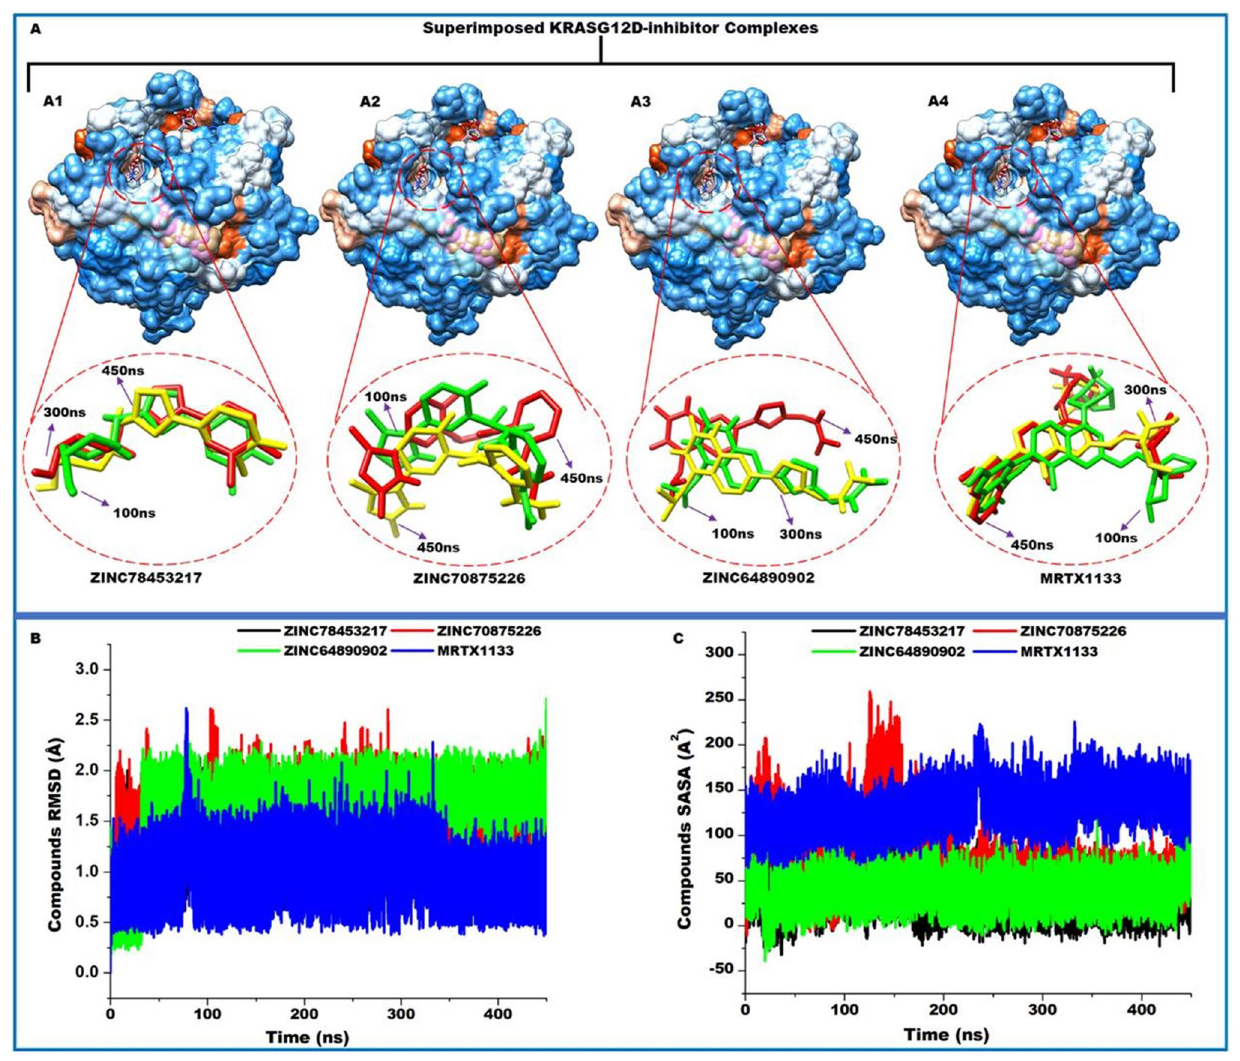
Figure 8. ( A ) Superimposition of KRAS G12D complexed with ZINC78453217, ZINC70875226, ZINC64890902 and MRTX1133. Insert shows the binding orientation of each inhibitor at 100 ns, 300 ns, and 450 ns. ( B ) Comparative inhibitor stability plots using RMSD metrics for ZINC78453217, ZINC70875226, ZINC64890902 and MRTX1133. ( C ) Comparative inhibitor SASA plots of ZINC78453217, ZINC70875226, ZINC64890902 and